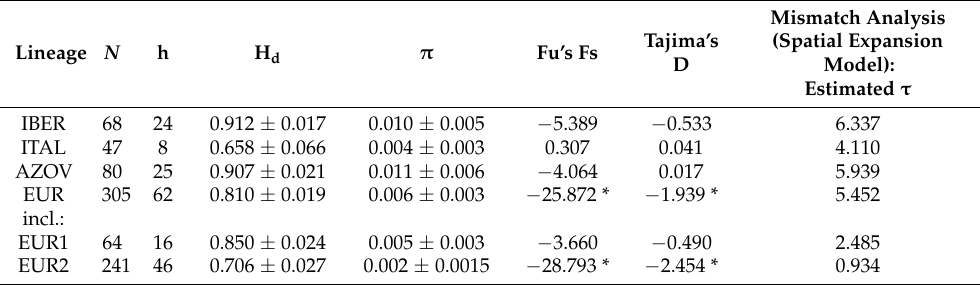
Table 2. Summary of genetic diversity indices estimated from the COI sequencing data for genetic lineages of A.anatina : sample size ( N ), number of haplotypes (h), haplotype diversity (H d ), nucleotide Table 1. Pairwise distances and F ST values between genetic groups of A. anatina ( p < 0.00001 for all diversity ( π ). The results of Fu’s Fs and Tajima’s D neutrality tests. Statistically significant values are F ST values). followed by an asterisk ( p < 0.05 for Tajima’s D and p < 0.02 for Fu’s Fs).